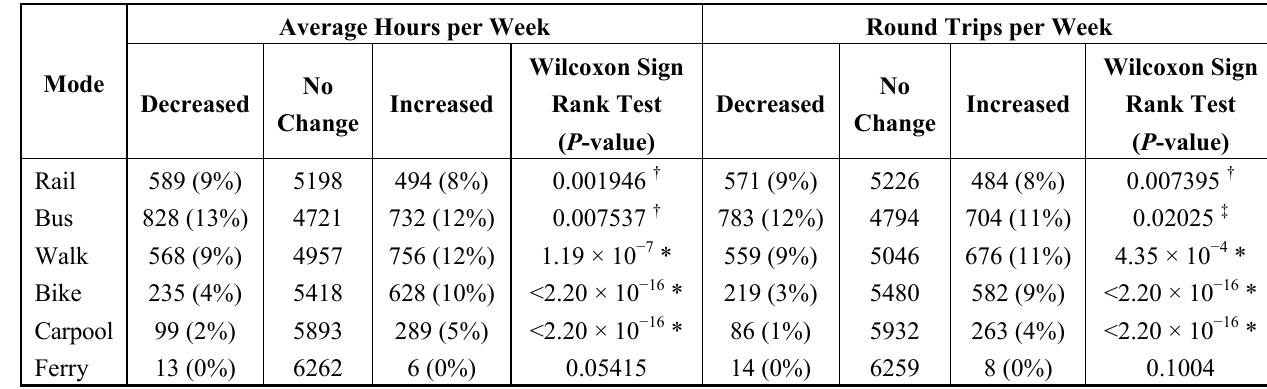
Table 2. Aggregate Shift in Public Transit and Non-Motorized